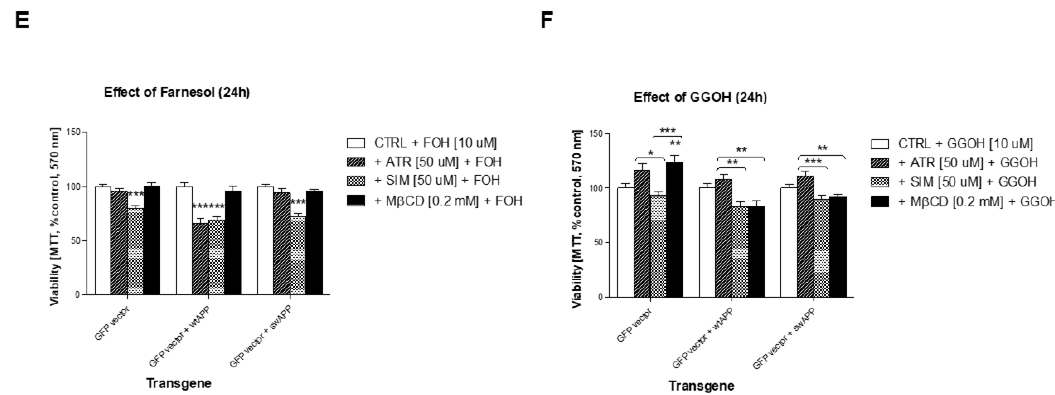
Figure 2. Effect of mevalonate (MEV, 100 µ M), dolichol (DOH, 0.1 µ g/mL), ubiquinol (UBOH, 10 µ g/mL), farnesol (FOH, 10 µ M) or geranylgeraniol (GGOH, 10 µ M) on cell viability affected chelator methyl- β -cyclodextrin (M β CD, 0.2 mM). One day (24 h) treatment with ( A ) ATR or